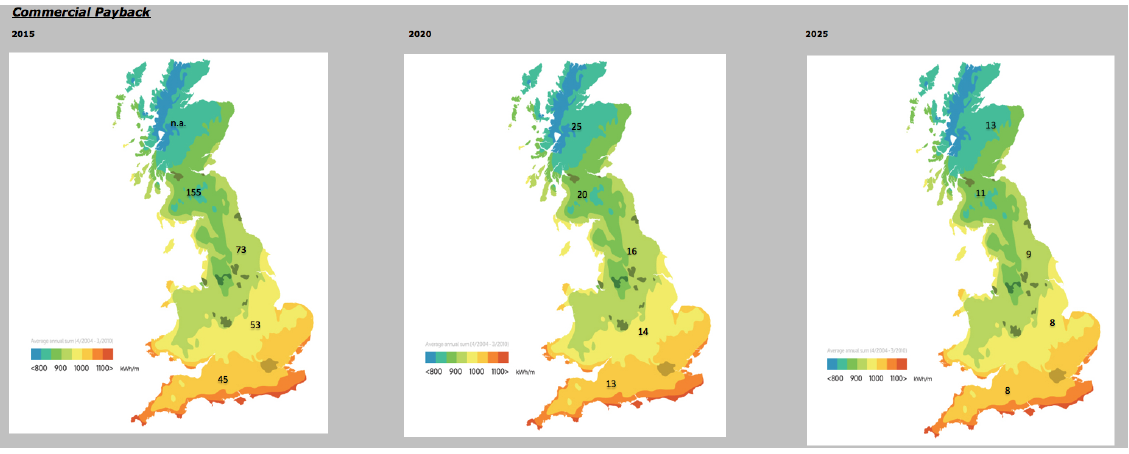
Figure 6. UK commercial rooftop payback periods, number of years,